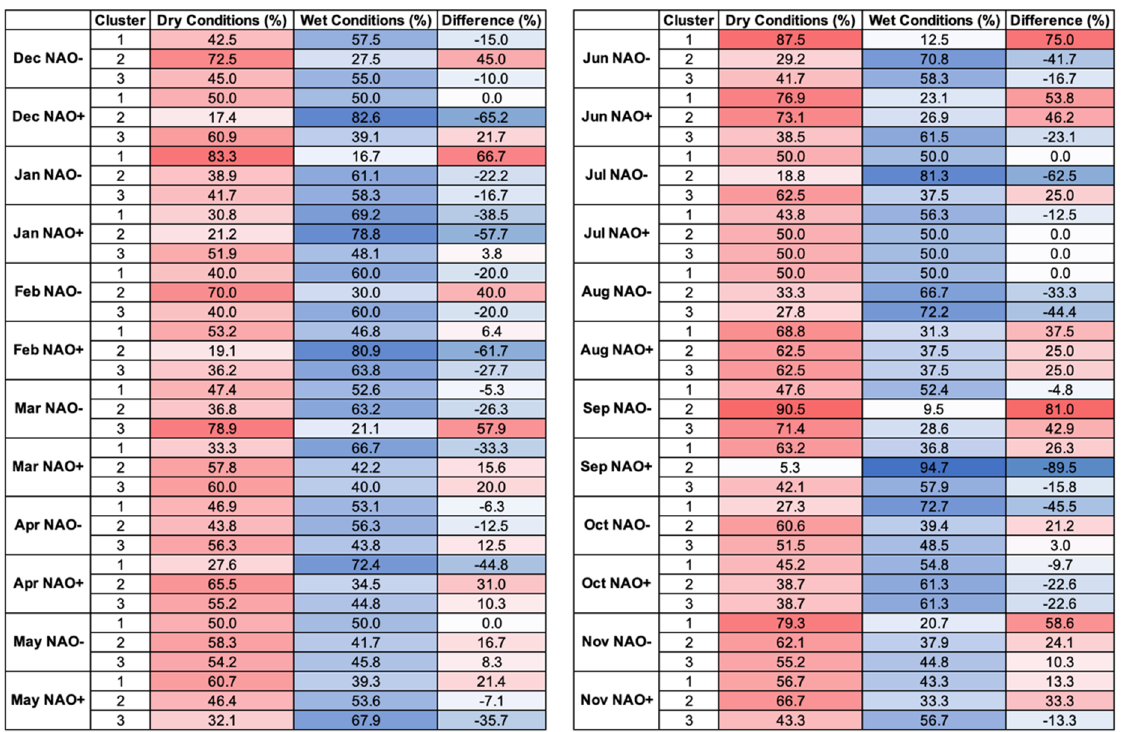
Figure 12. Percentage of time the cluster median SPI-1 value is wet (positive SPI-1 values) and dry (negative SPI-1 values) based on the frequency histograms in Figure 11. The difference value represents the difference between the percentage of time under dry conditions and wet conditions.